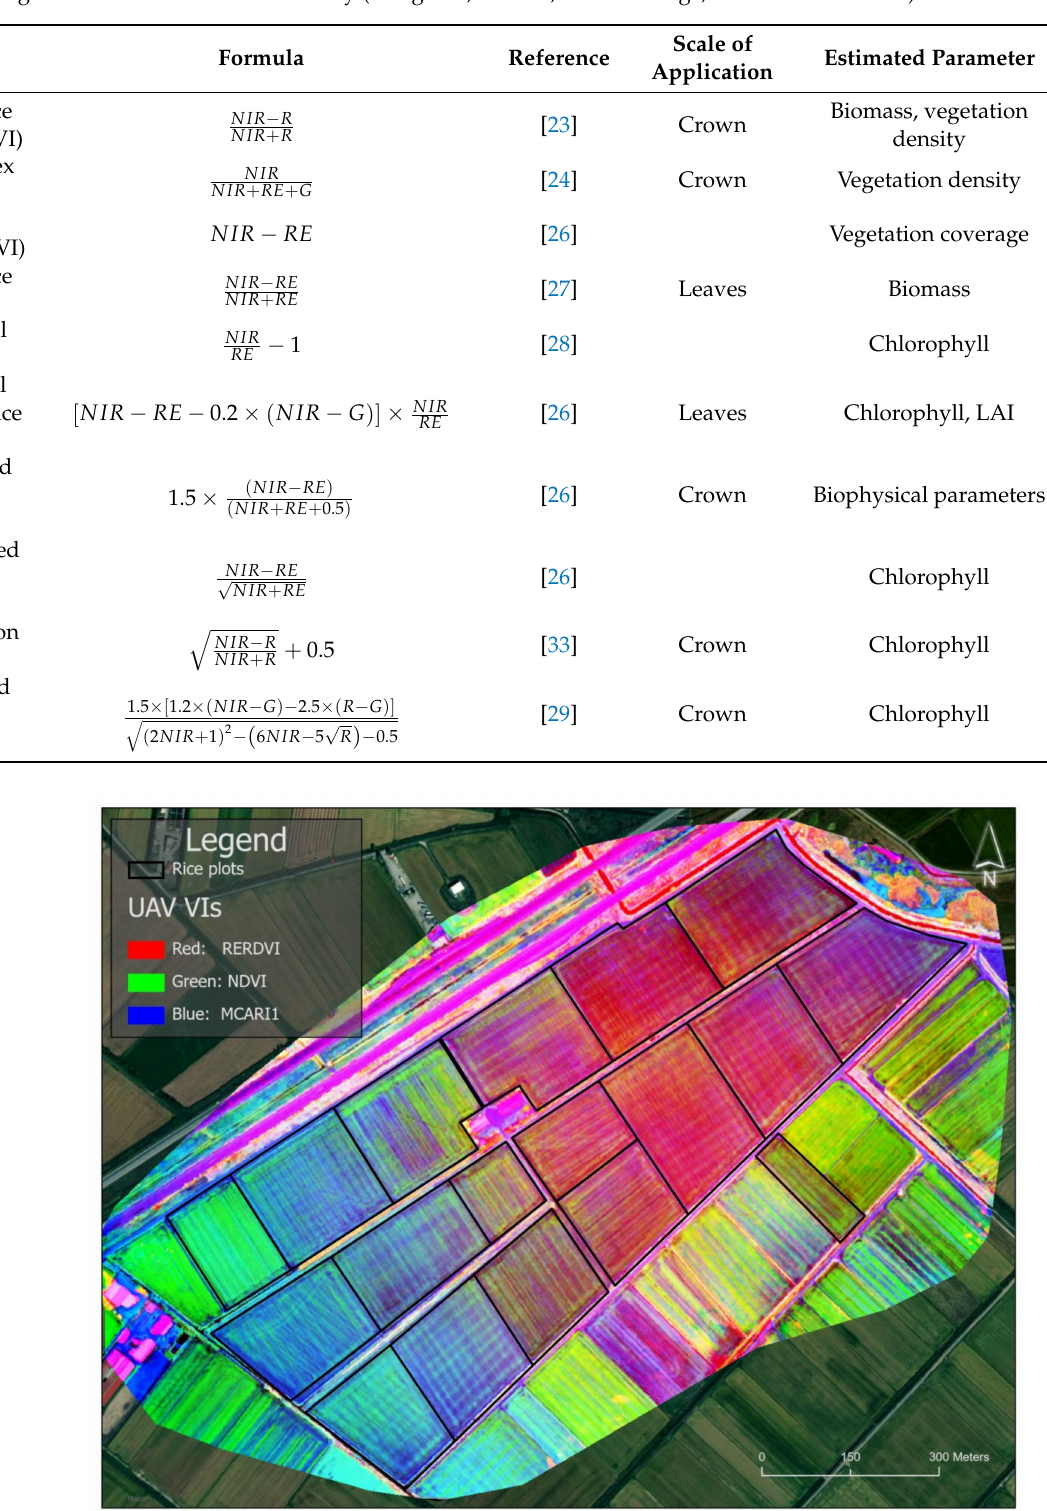
Table 1. Vegetation indices used in this study (G = green, R = red, RE = red edge, NIR = near infrared).